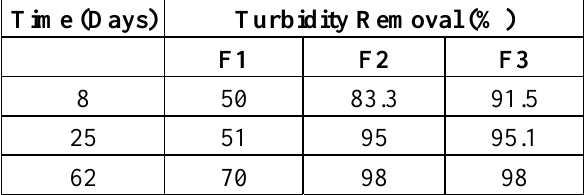
Table 8. Percentage turbidity removal from raw water for the three filter experiments. Time (Days) Turbidity Removal (%)